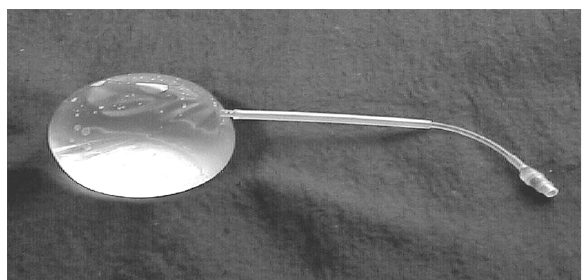
Figure 4 – Vesical silicone modeler.